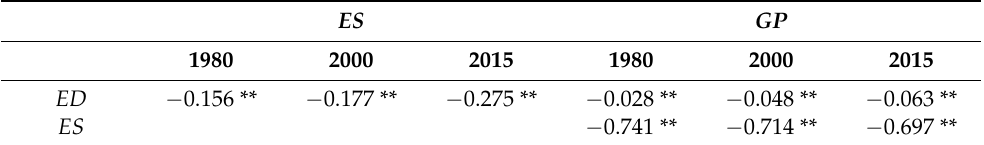
Table 6. Correlation coefficient between functional values of land system in Xi’an from 1980 to